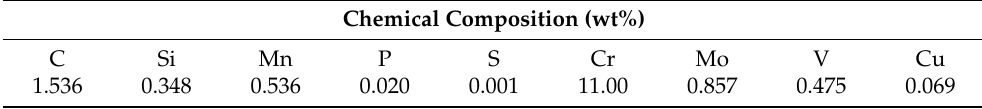
Figure 4. Information of milling insert and cutting processing parameters. Table 1. Chemical composition of the SDK-11 workpiece used in the experiments.